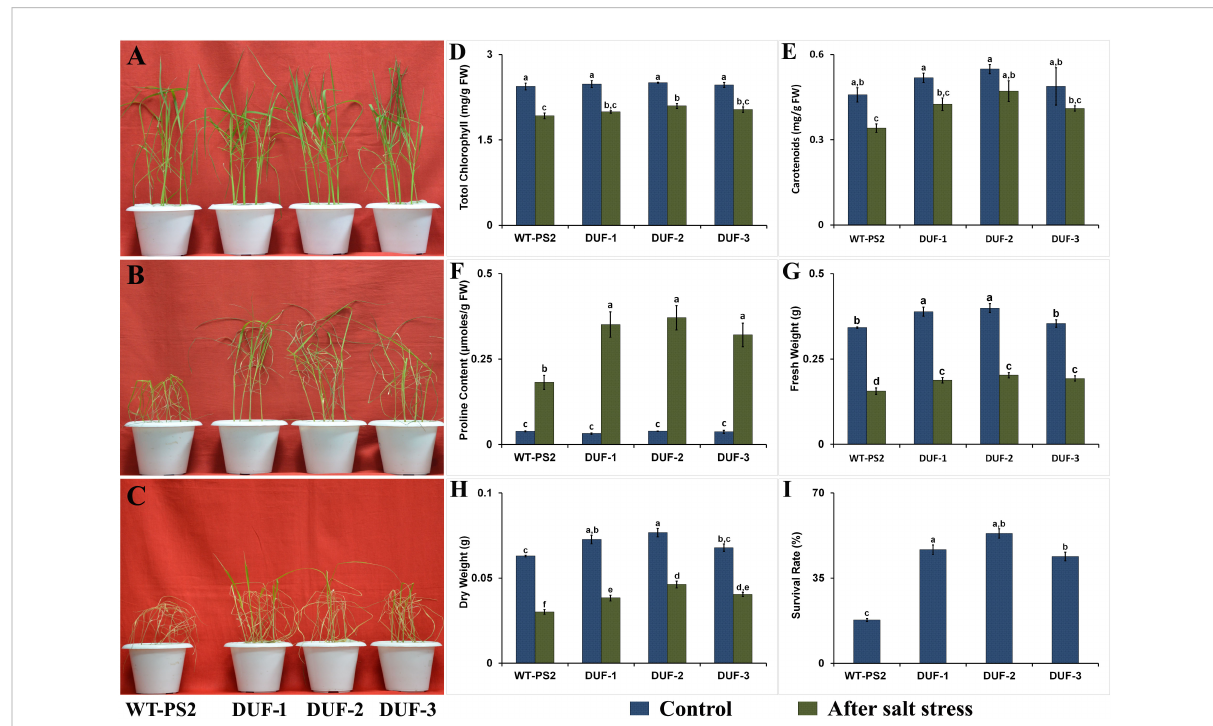
FIGURE 5 Salt stress analyses of wild-type and OsSRDP transgenic rice plants. (A) The seedlings of WT and AtRd29A::OsSRDP transgenic lines were grown in basal nutrient solution (Yoshida ’ s solution) under normal conditions. (B) Then, the fourth to fi fth leaf stages of both rice seedlings were transferred into nutrient solution containing 150 mM NaCl for 7 days and (C) recovery for 6 days in basal nutrient solution. (D) Total chlorophyll, (E) carotenoid content, (F) accumulation of proline content, (G, H) relative fresh and dry weight of AtRd29A::OsSRDP transgenic lines and WT seedlings under control and salt stress conditions, respectively, and (I) the survival rate of WT and AtRd29A::OsSRDP transgenic rice lines following 7 days of salt treatment. Each value is the average of three independent biological replicates, and the vertical bar indicates ± SD. Standard error of means (SD/ √ N; N = 3) are used as error bars, and alphabets above the vertical bars represent statistically signi fi cant differences (Duncan ’ s Multiple Range Test: p ≤ 0.05) between WT and AtRd29A::OsSRDP transgenic